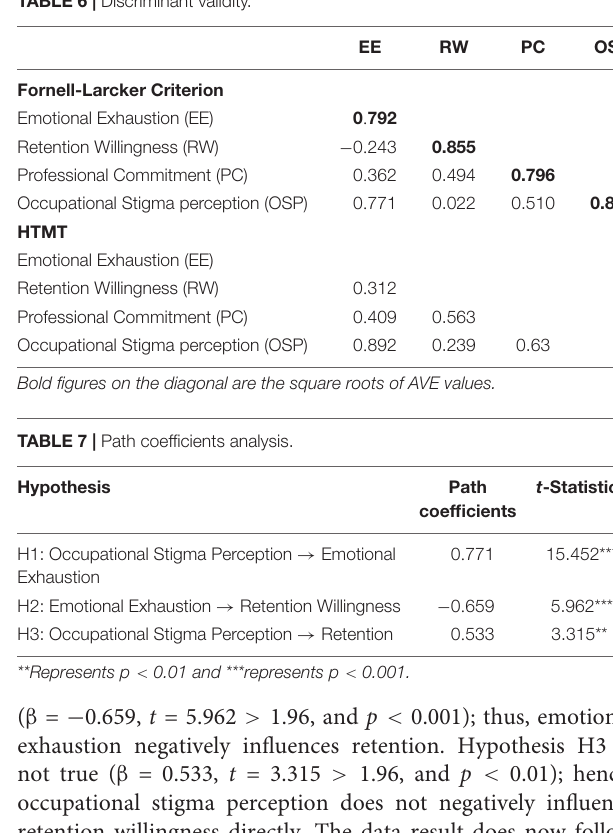
TABLE 8 | Mediating effects of